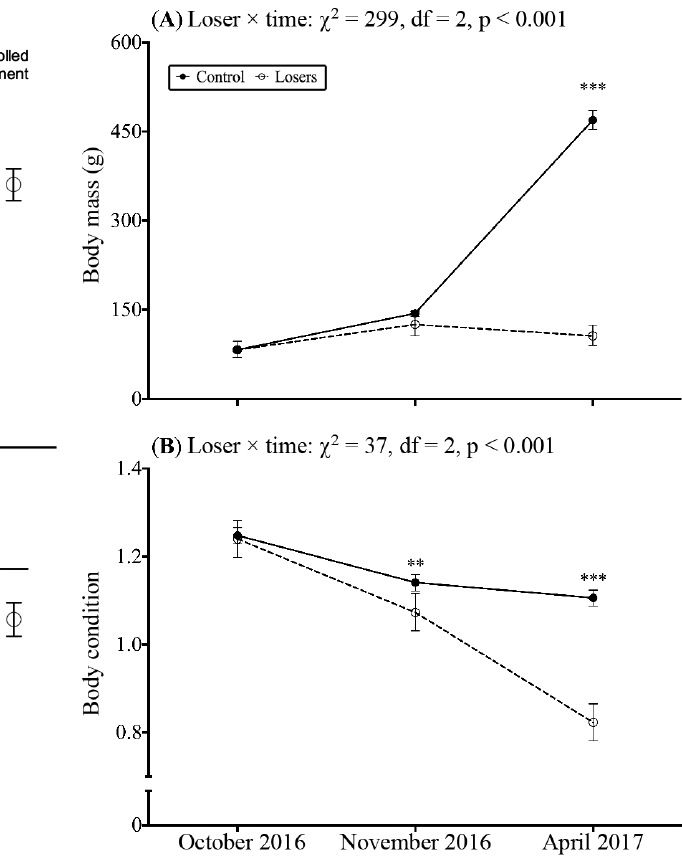
Fig. 5. Body mass and condition of Atlantic salmon reared at 17°C and 60% O 2 saturation for 7 wk followed by a further 28 wk in a sea-cage. (A) Body mass and (B) body condition for ‘losers’ and control individuals over time. Data include Fig. 4. Effect of (A) water temperature and (B) oxygen satu- means ± 95% CI (n = 13−140 group −1 time −1 ). Asterisks indi- ration at vaccination on antibody titres over time in vacci- cate a significant loser effect within a given time point (post nated Atlantic salmon. The results from linear models are hoc, least square means, ** p < 0.01), *** p < presented. Data are means ± 95% CI (n = 20 group −1 time −1 ). Asterisks indicate a significant effect of temperature/O 2 saturation within a given time point (post hoc, least square means, * p < 0.05, *** p < 0.001) showed some overlap with normal fish (6 of the 1354 ‘normal’ fish had a CF <0.94, but these 6 fish all weighed >290 g). In all instances, the models for body mass and body condition that included an inter- action between losers and time had a lower BIC score than the model without the interaction (body mass, −158 vs. 35; body condition, −955 vs. −933 for models with and without the interaction, respectively), pro- viding evidence that loser effects are transient over time. Subsequent analysis showed that losers were equal in body mass and condition compared to ‘nor- mal’ fish in October 2016, equal in body mass but with a lower condition in November 2016, but had significantly lower mean body mass and condition in April 2017 (Fig. 5).